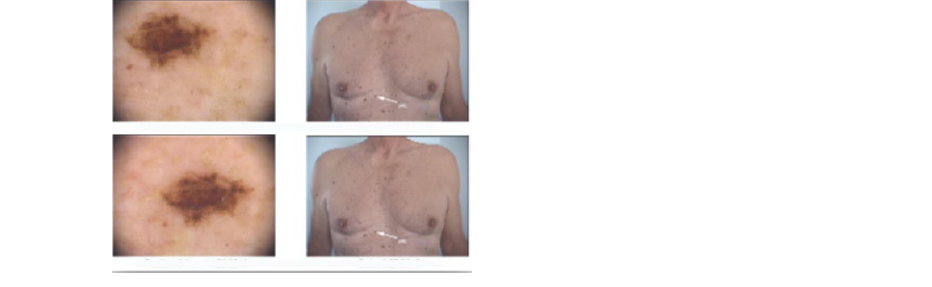
Figure 3. Clinical and dermoscopical images of two more dysplastic nevi on the anterior thorax.